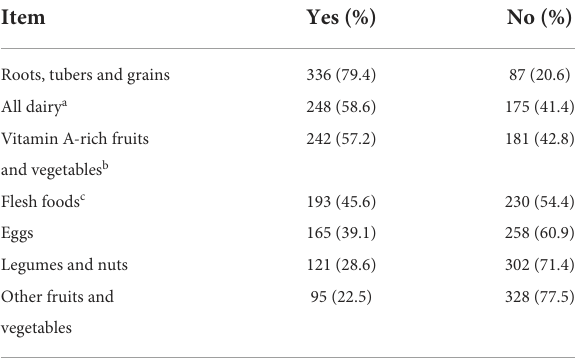
TABLE 3 Food groups consumed the preceding 24-h by children 6–23